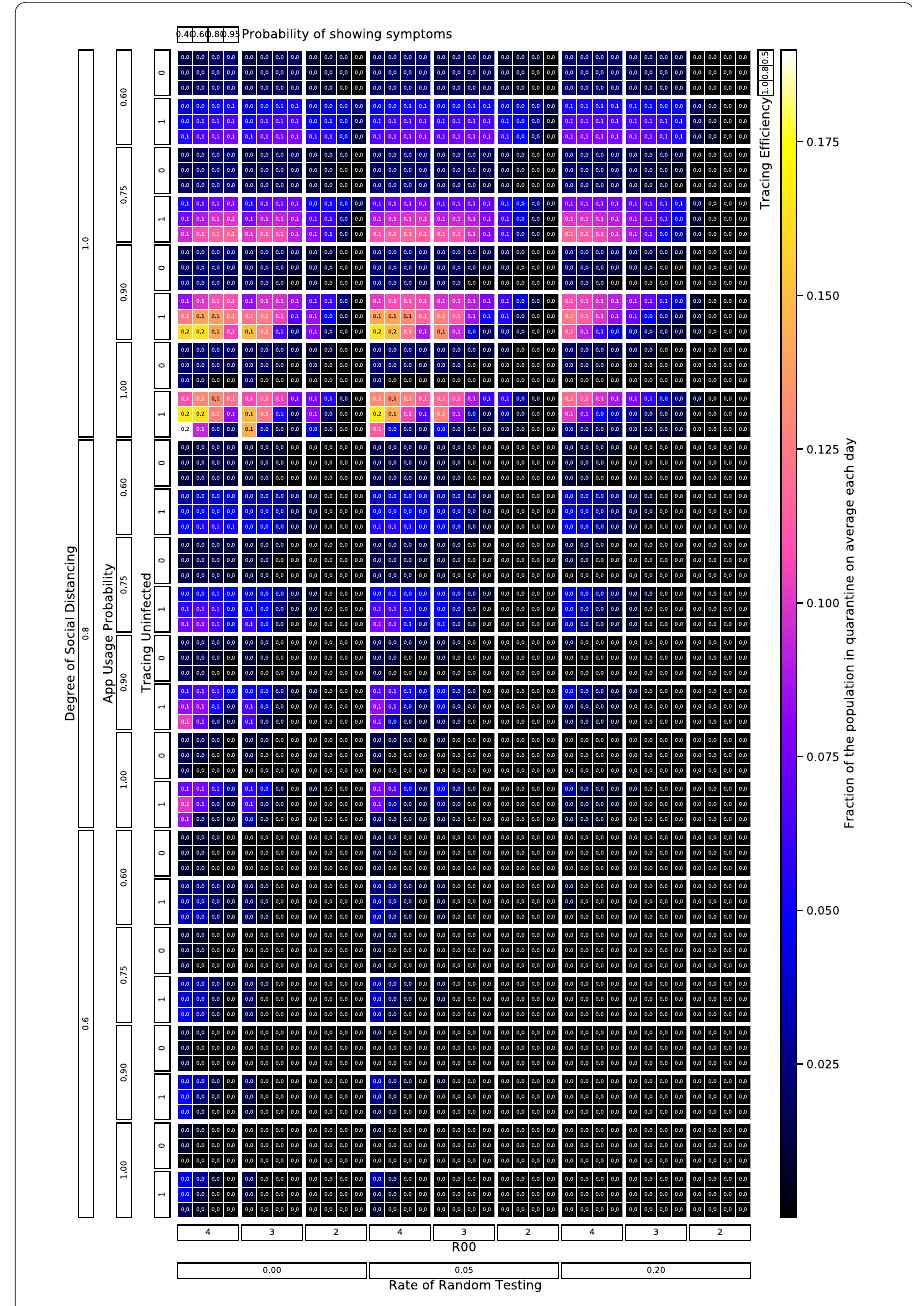
Figure 24 The fraction of the population quarantined on average over one year of the outbreak is shown for all combinations of parameters in the default parameter scan (black font color in Tab. 1)